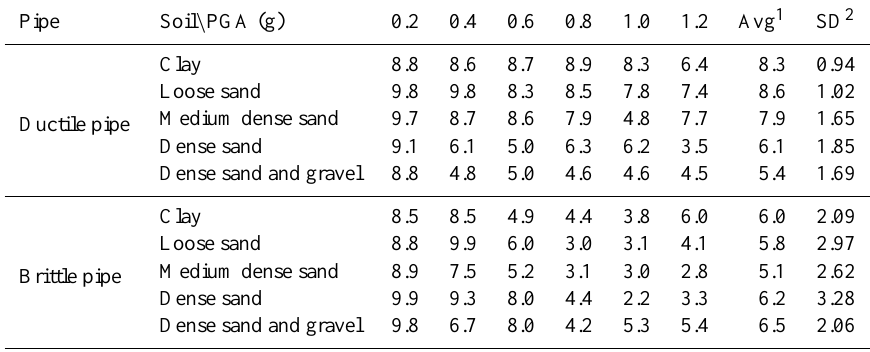
Table 6. Mobilized strain difference (%) of pipeline modeled based on Korea and US design criteria and construction specification. Pipe